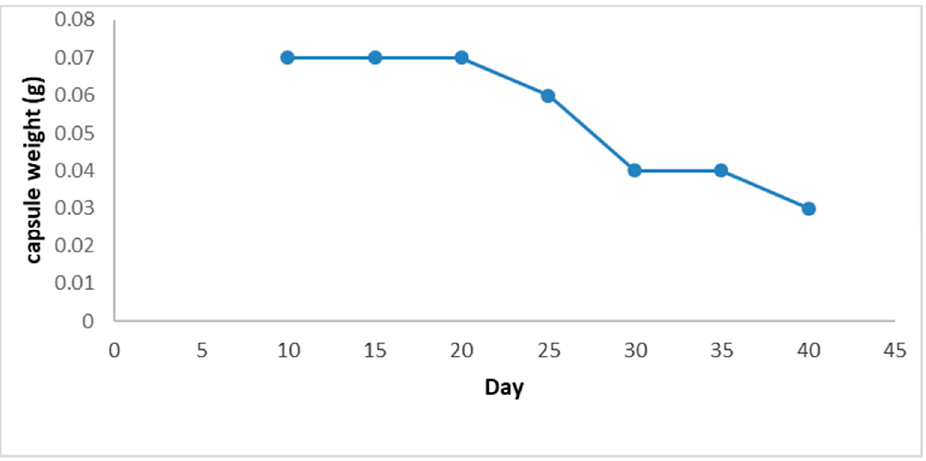
Figure 6. EO chitosan capsule weight stability.